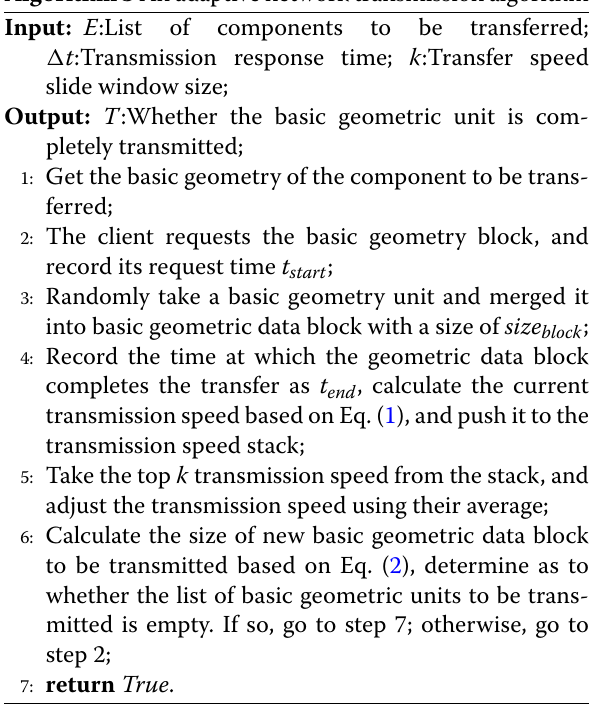
Algorithm 3 An adaptive network transmission